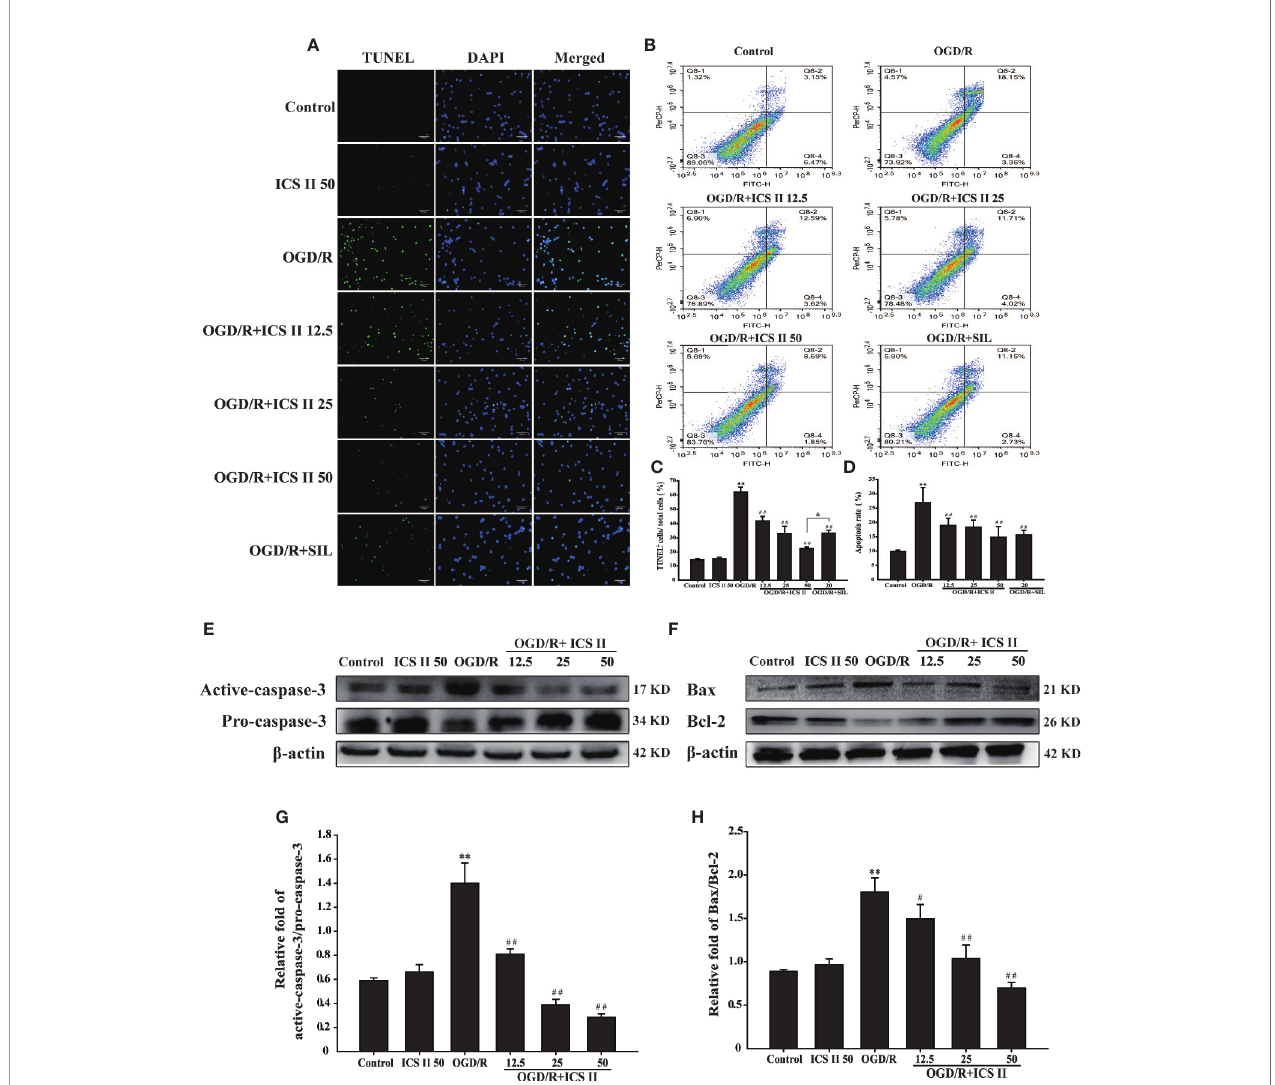
FIGURE 2 | ICS II mitigated OGD/R-induced hippocampal neurons apoptosis. (A) Apoptosis cells determined with TUNEL staining (green). (B) Neuronal apoptosis rates were determined with AV/PI double staining. (C) Statistical results of TUNEL positive neurons/total neurons. (D) Statistical results of apoptosis rate at early and late stage. (E) Representative Western blot images of cleaved-caspase-3 and caspase-3. (F) Representative Western blot images of Bcl-2 and Bax. (G) Quantitation of activated-caspase-3/caspase-3. (H) Quantitation of Bax/Bcl-2. Data are presented as means ± SD (n = 3). ** P < 0.01 versus control group; # P < 0.05, ## P < 0.01 versus OGD/R group; & P <0.01 versus OGD/R + ICS II 50